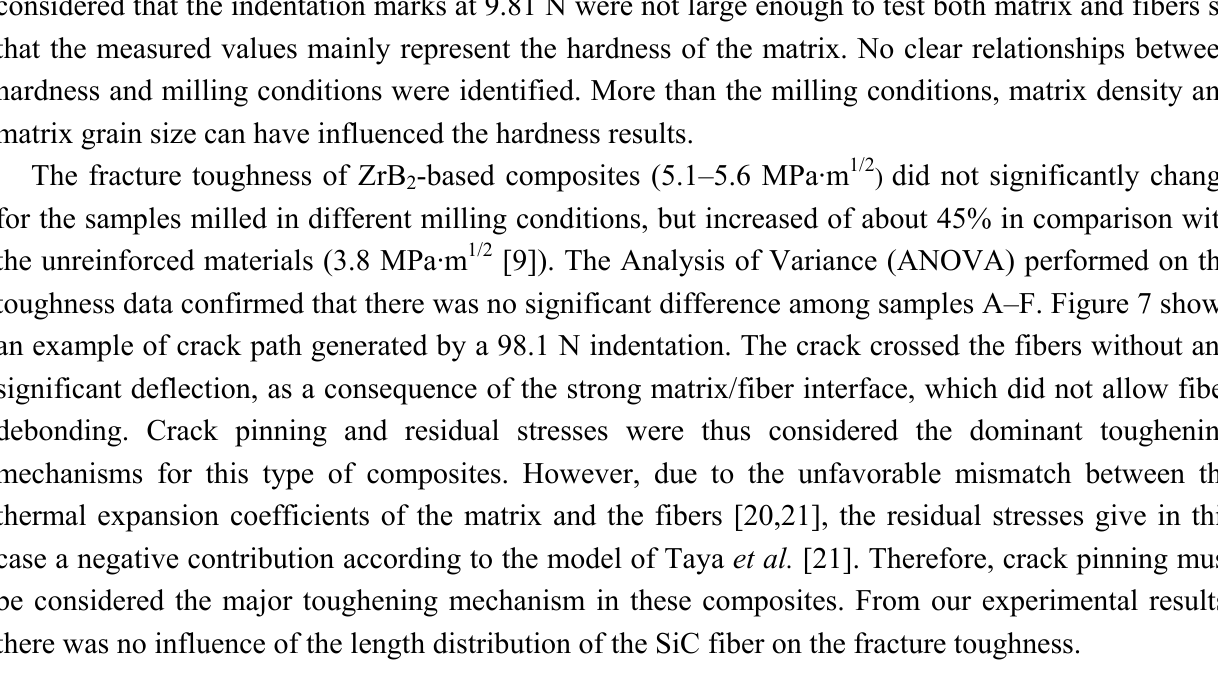
), flexural strength ( σ Ic